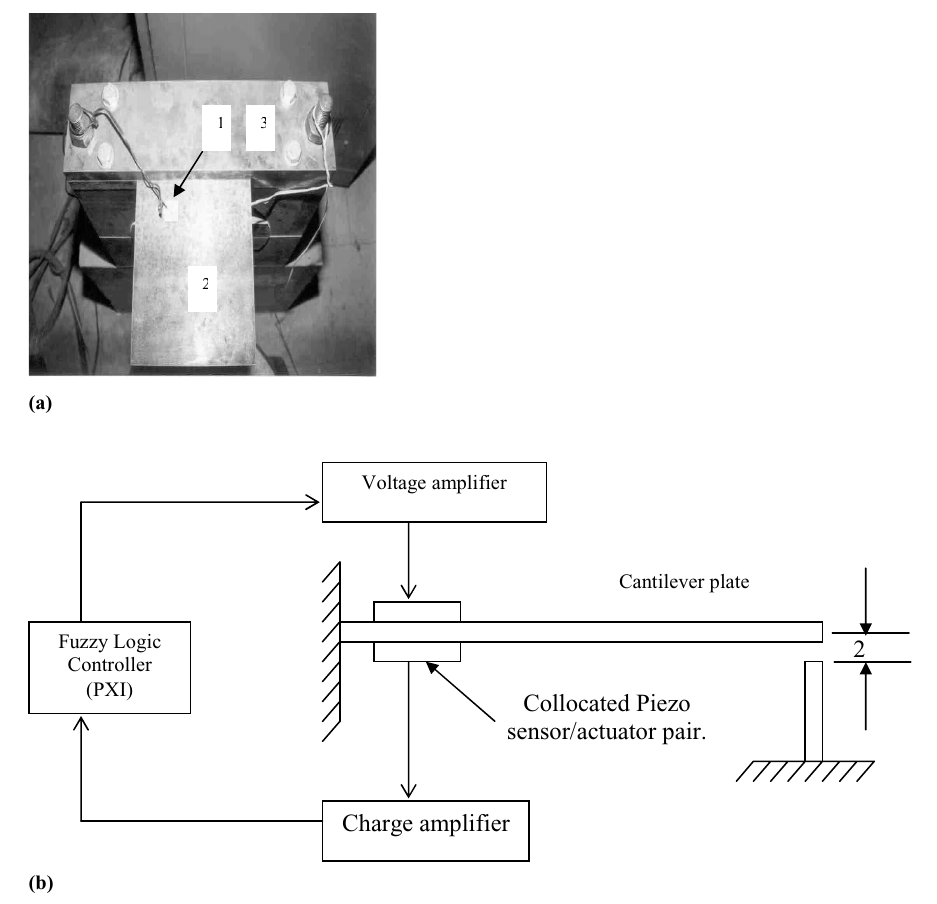
Fig. 9. (a) Smart plate with single actuator scheme, 1. piezoelectric patch, 2. cantilevered plate and 3. mechanical clamp. (b) Schematic diagram of the experimental set up.